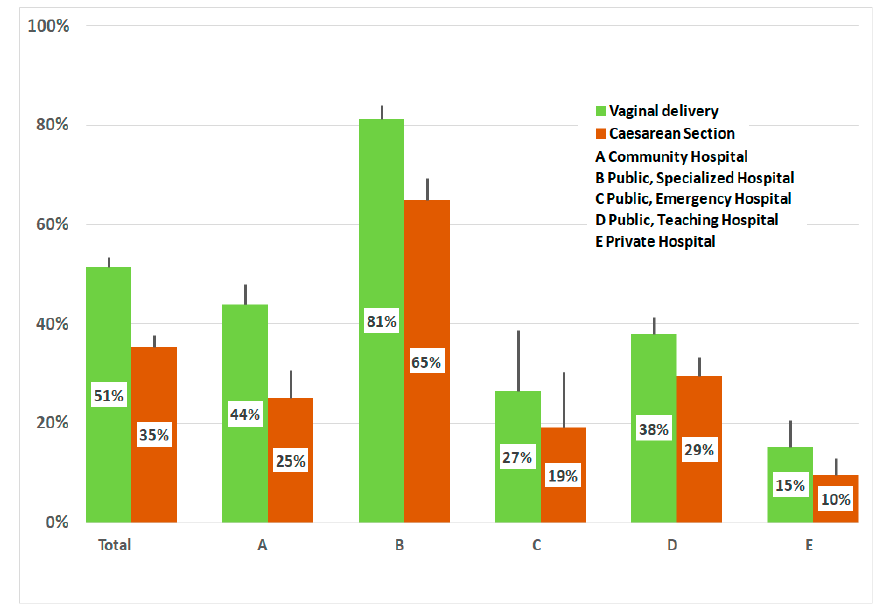
Figure 3. Percentages of exclusive breastfeeding in vaginal and caesarean delivery in various types of hospitals. Vertical lines indicate 95% CI.